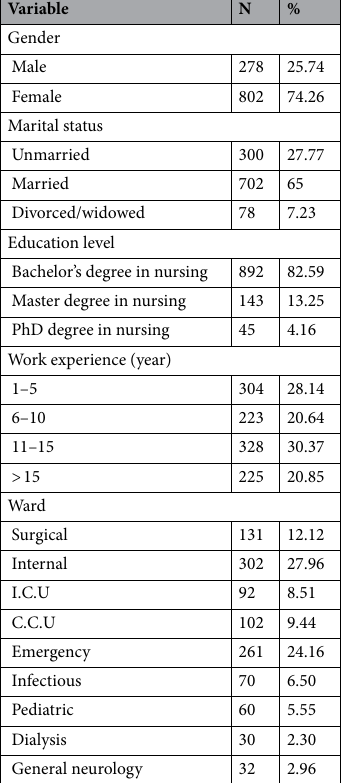
Table 1. Frequency distribution of demographic characteristics (n =